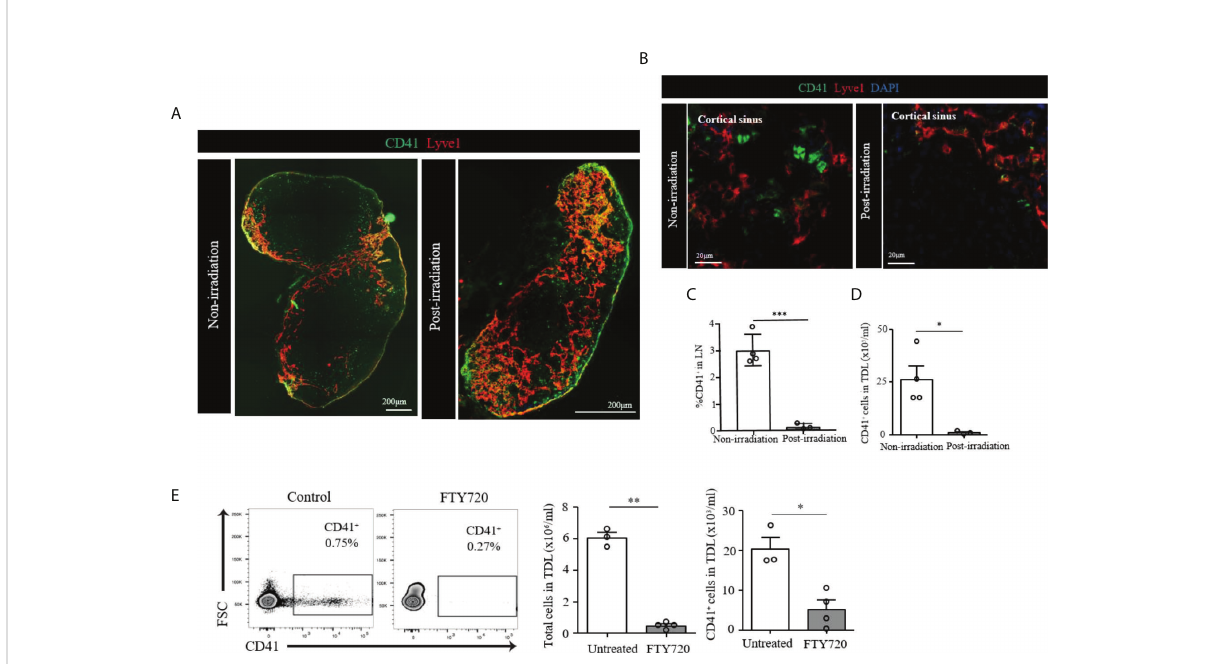
FIGURE 4 (A) Scanning image of whole axillary LN after irradiation showed a marked decrease of size compared to unirradiated LN. (B) Confocal images showed disappearance of CD41 + Lyve1 - cells in the LN of post-irradiated mouse as compared to the LN of non-irradiated mouse. CD41 (green), Lyve1 (red) and DAPI (blue). (C) Flow cytometry assessment of LNs post-irradiation showed a marked decrease in CD41 + cells compared with the non-irradiation group (*** p <0.001, n=3-4 mice/group). (D) Flow cytometry analysis showed signi fi cantly decreased CD41 + cell density in the TDL from an irradiated mouse compared with the TDL from a non-irradiated mouse (* p <0.05, n=3-4 mice/group). (E) The percentage of CD41 + cells were decreased in the TDL of mice treated with FTY720. The total number of cells in the TDL (** p <0.01, n=3-4 mice/group) and the absolute number of CD41 + cells were signi fi cantly decreased in FTY720-treated mice (* p <0.05, n=3-4